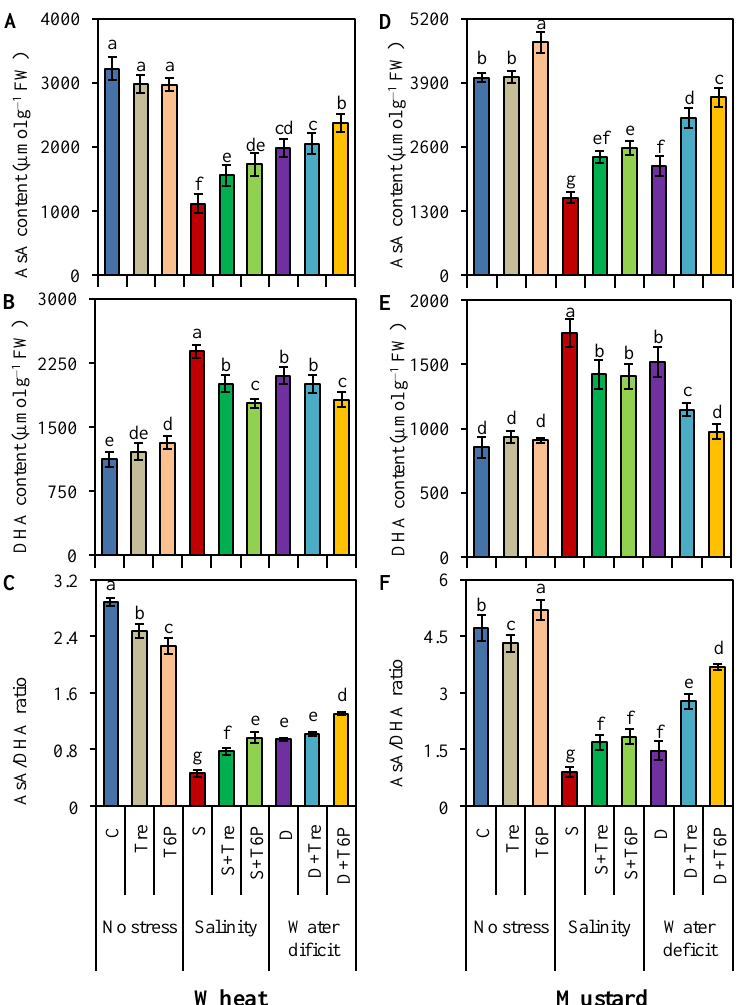
Figure 3. Effect of trehalose and T6P on AsA, DHA, and AsA/DHA ratio in wheat and mustard seedlings. Wheat seedlings were grown in a hydroponic solution containing 300 mM NaCl for 9 days. Mustard seedlings were grown in 200 mM NaCl for 10 days. For water deficit treatment, wheat seedlings were treated with 20% PEG, while mustard was treated with 12% PEG for four days. C, control; ( A – C ) wheat; ( D – F ) mustard; Tre, 200 µM trehalose;T6P, 200 µM trehalose 6-phosphate; S, NaCl treatment; D, water deficit treatment with PEG 6000. Means were calculated from three replicates for each treatment, and the bars represent the standard deviation (±SD). Values with different letters are significantly different at p ≤ 0.05 by Fisher’s LSD test.